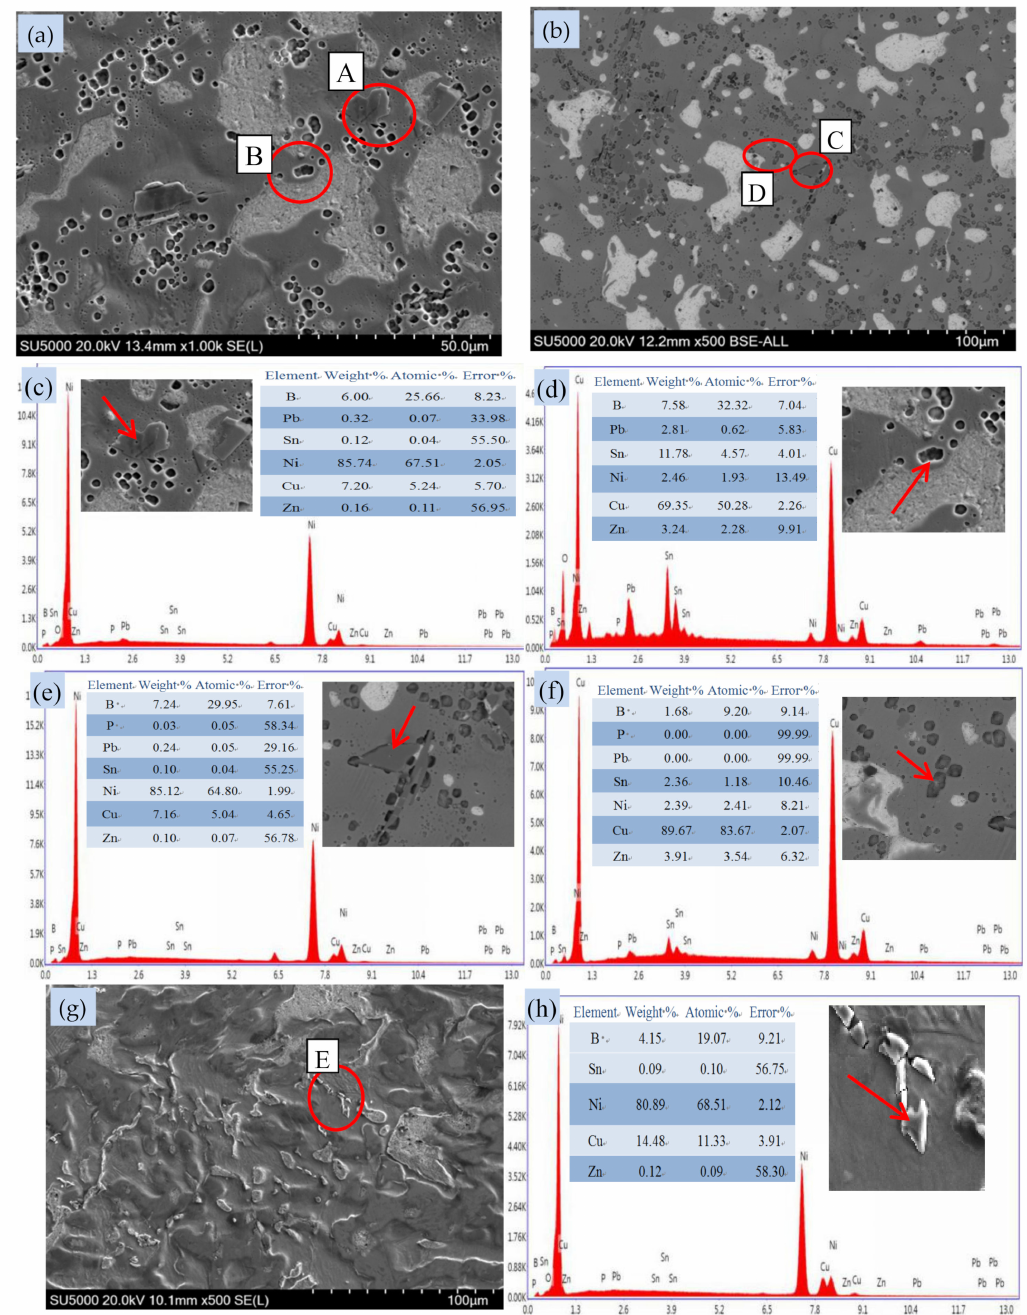
Figure 9. Microstructure of alloy ZCuPb20Sn5Ni3-0.1P-yB phase. ( a ) SEM of alloy with 0.1 wt.% B; ( b ) SEM of alloy with 0.2 wt.% B; ( c ) EDS of A; ( d ) EDS of B; ( e ) EDS of C; ( f ) EDS of D; ( g ) SEM of alloy with 0.2 wt.% B; ( h ) EDS of